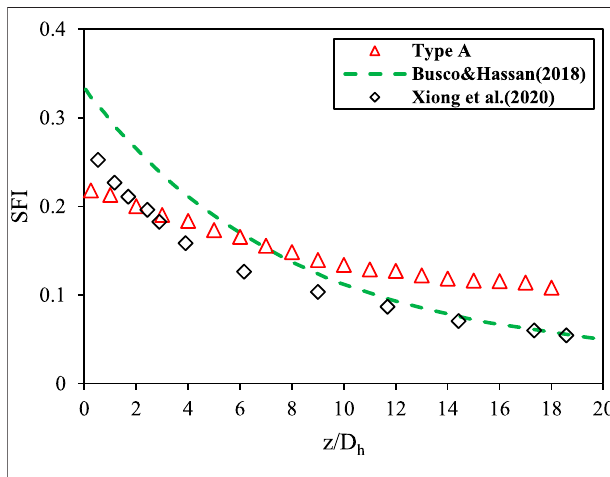
FIGURE 2 | Comparison of simulated and experimental secondary fl ow